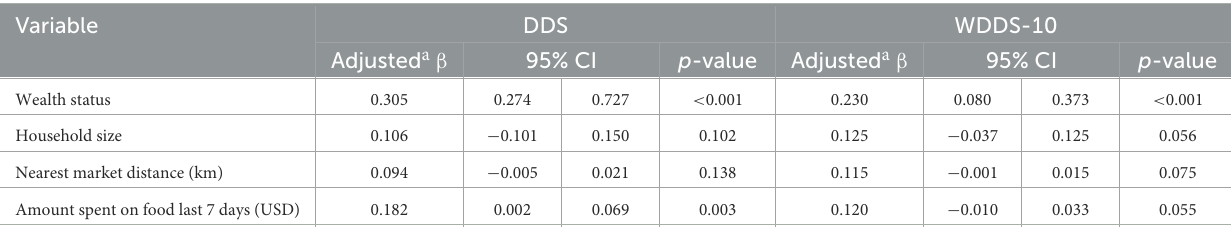
TABLE 5 Multivariate regression analysis of the relationship between dietary diversity scores (DDS) and women’s dietary diversity scores (WDDS-10) and sociodemographic factors.